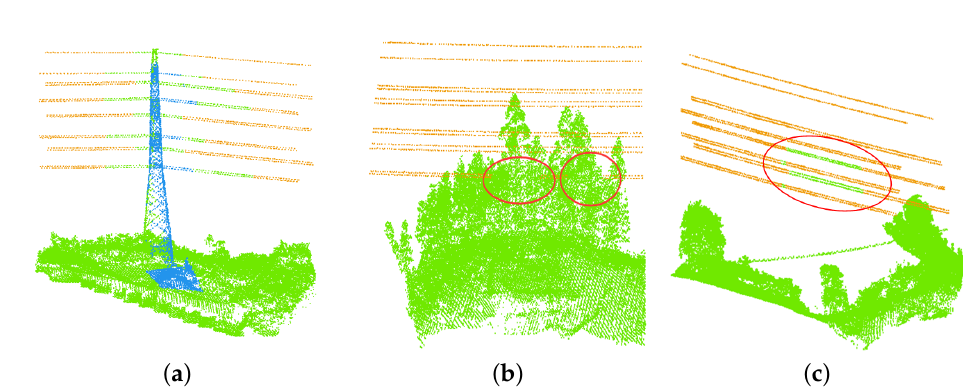
Figure 6. Typical cases where power line points need to be completed. ( a ) The power line points near the pylon are classified mistakenly after region growing. ( b ) The power line points close to the ground objects are occluded, resulting in the missing of power line points in the red circle. ( c ) The green points in the red circle are lost because of the mirror reflection on the water surface.